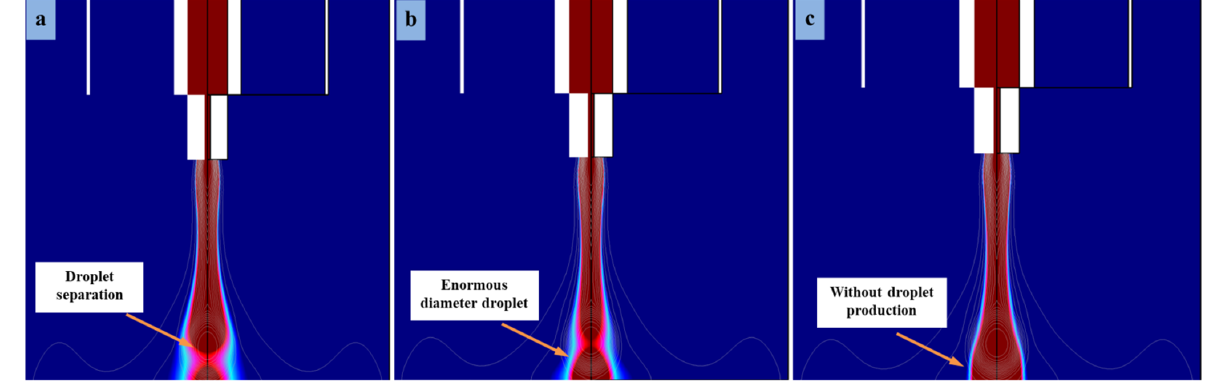
Figure 9. Different-sized microdroplets generated at different applied flow rates: ( a ) 8.6 × 10 − 10 m 3 s − 1 , ( b ) 3.7 × 10 − 8 m 3 s − 1 , and ( c ) 4.07 × 10 − 8 m 3 s − 1 .